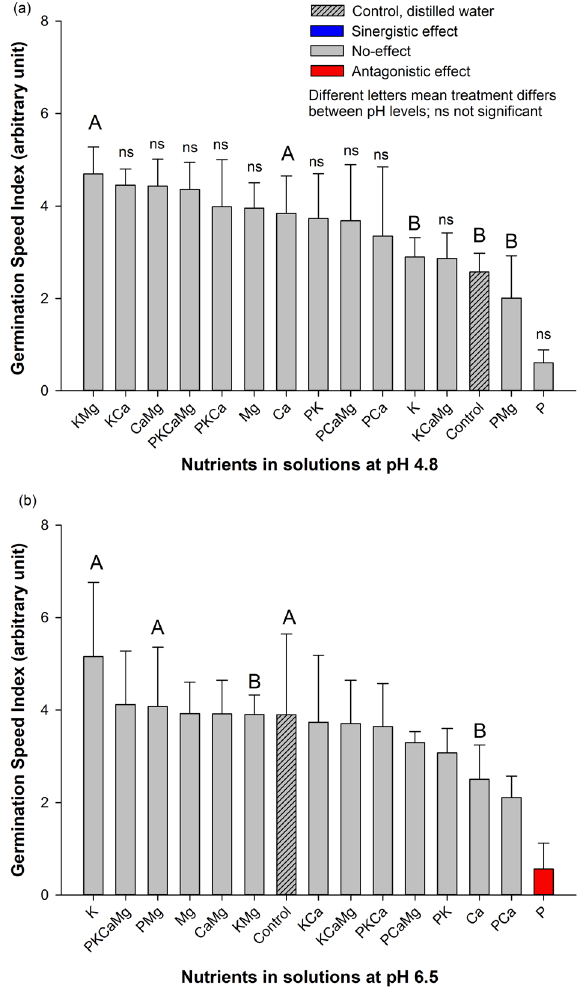
among treatments, are significantly different, according to the Tukey’ test ( p < 0.05). Different letters represent a statistical difference for the same treatment between the two pH tested while ns represents not significant; The results in the Bars represent means, while error bar marks represent standard deviation ( n = 4) from the mean